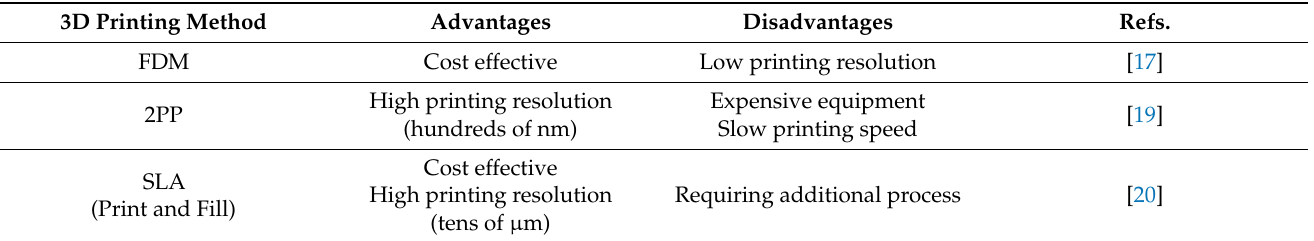
Table 1. The advantages and disadvantages of various microneedle manufacturing